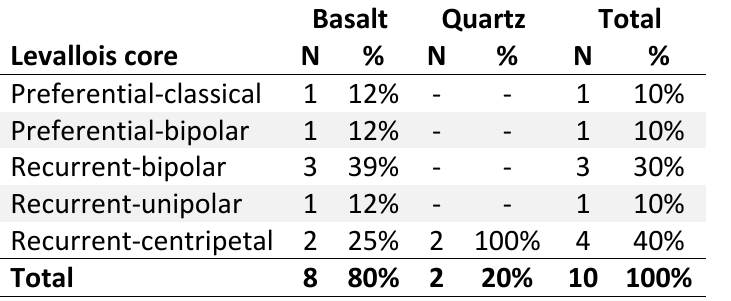
Table 11. Levallois core types from GOT